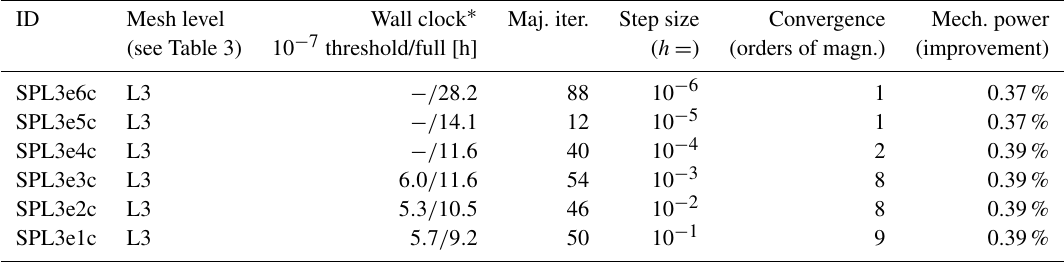
Table 5. Overview of six CFD-based shape optimizations of wind turbine blade tips using different finite difference step sizes. Operational conditions are found in Table 2. The naming convention explanation using “SPL3e2c” as an example is as follows. SP: a single-point optimization; L3: on mesh level L3; e2: using a finite difference step size of 10 − 2 ; and c: (cold-)started from a straight baseline configuration. All optimizations were carried out using 648 CPUs split into 12 groups – one group of 54 CPUs for each design